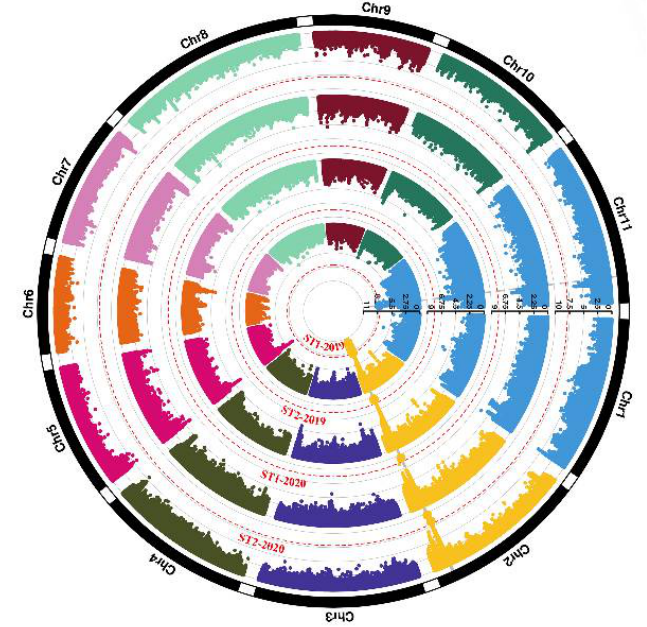
Figure 4. Circular Manhattan plots of a genome-wide association study (GWAS) for pod stringlessness. The inner circle to the outer circle represents ST1-2019, ST2-2019, ST1-2020, and ST2-2020, respectively. The red dashed lines of each circle indicate the threshold (7.86). Single-nucleotide polymorphisms (SNPs) over the threshold are highlighted.